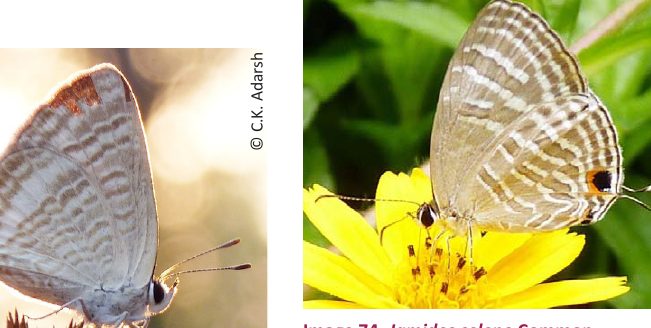
Image 74. Jamides celeno Common